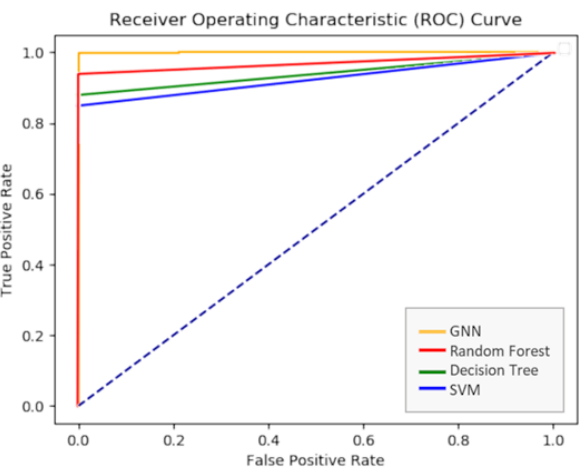
Figure 7. Detection efficiency against the denial-of-service attack, with a number of devices unavail- able while impacted by the